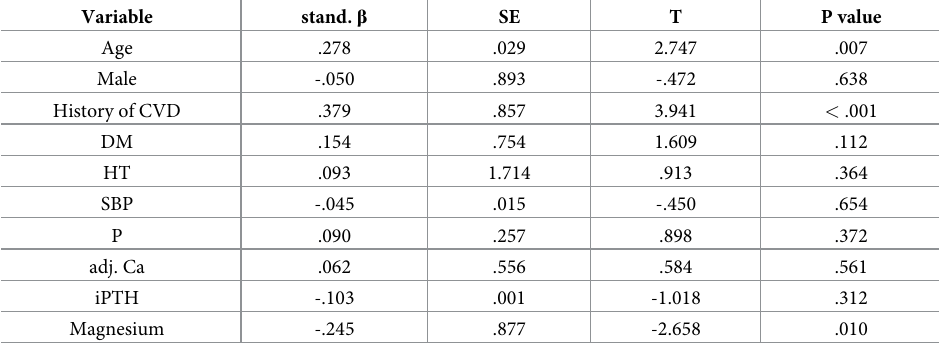
Table 3. Multiple linear regression for AAC volume.